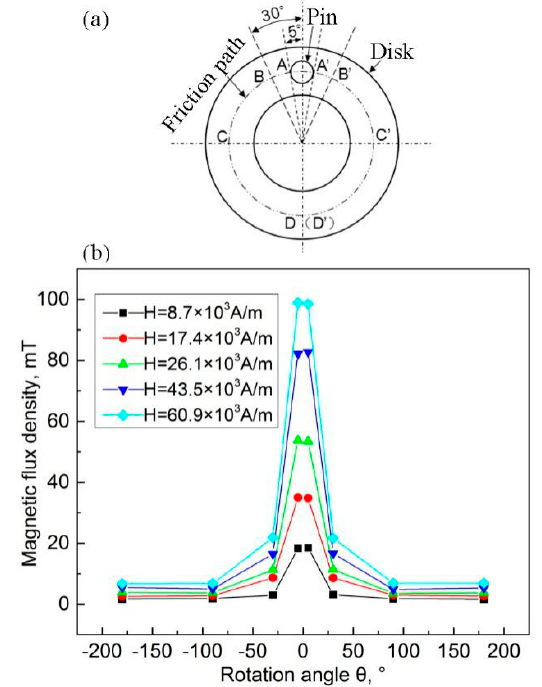
Figure 2. Measurement of magnetic induction intensity. ( a ) Measured location and ( b ) measured values.